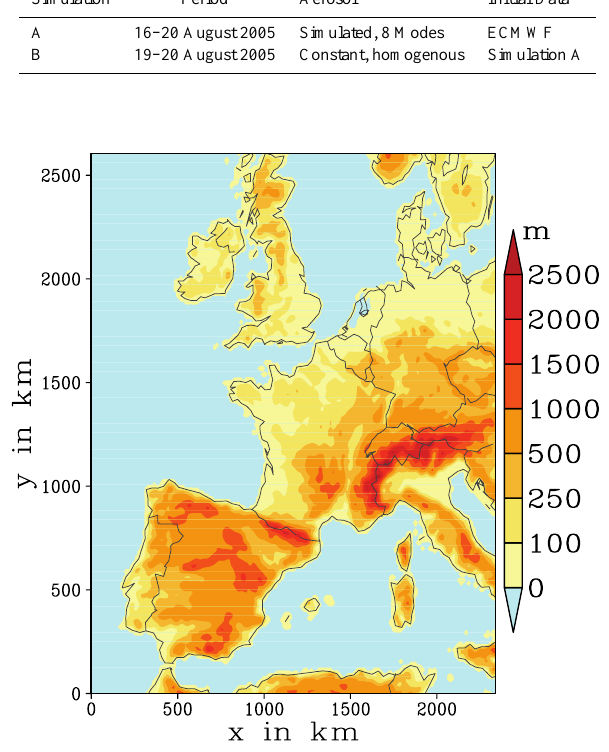
Fig. 2. Terrain height within the model